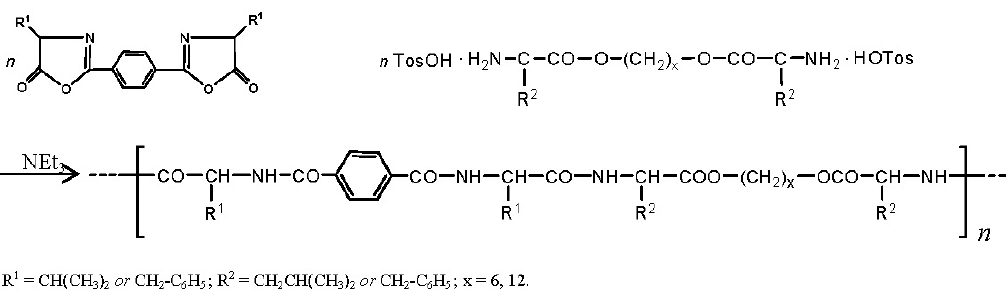
Figure 41. Synthesis of dipeptide-containing AABBP via bis-azlactones.